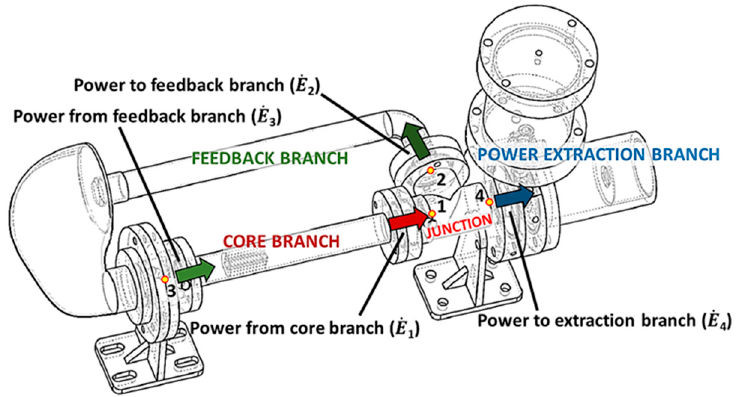
Figure 3. Schematic illustration of the distribution of acoustic power circulating through the three feedback branches in the TA-SLiCE prototype.